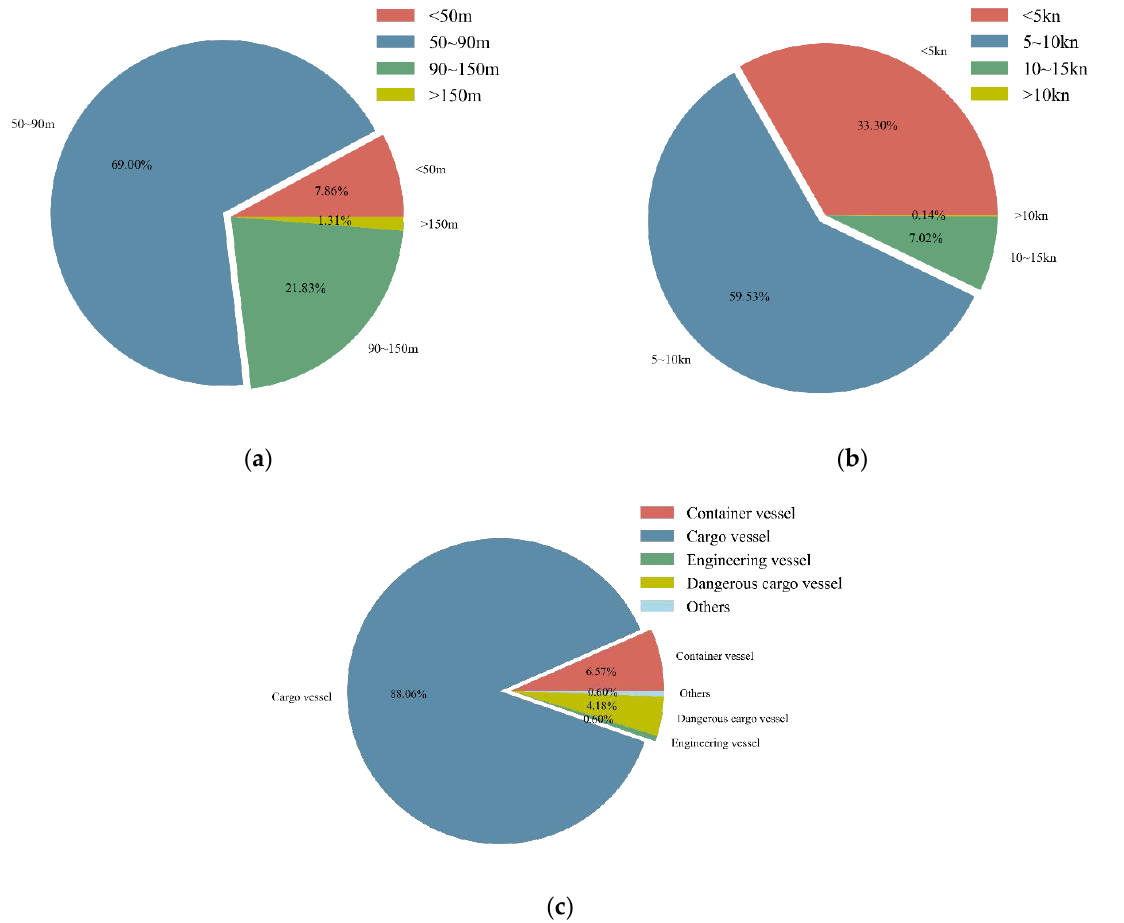
Figure 4. Distribution of vessel traffic flow characteristics: ( a ) distribution of vessel length; ( b ) distribution of vessel speed; ( c ) distribution of vessel style.